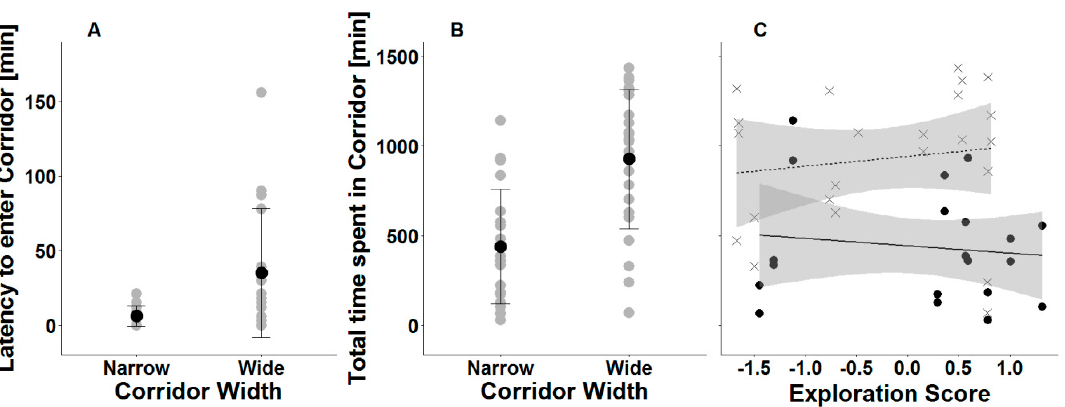
Figure 2. Movement in the corridor system. ( A ) Original values, means, and standard error of latencies of N = 33 to enter the corridor for the first time depending on corridor width. ( B ) and ( C ) The total time N Day1 = 22 and N Day2 = 21 male common voles spent in a grassland corridor within 24 h. ( B ) Original values, means, and standard error. ( C ) Modelled values from mixed e ff ects model, including the terms month and experimental day (two days per individual) as covariates, with ID and ID of the second male in pair as random factors. Dots represent animals in the narrow corridor and crosses represent animals in the wide corridor. Each animal is represented by two symbols (same exploration score, but di ff erent days). The solid line represents the regression slope for the narrow corridor and the dashed line represents the regression slope for the wide corridor. The grey bands display the confidence interval of the model.